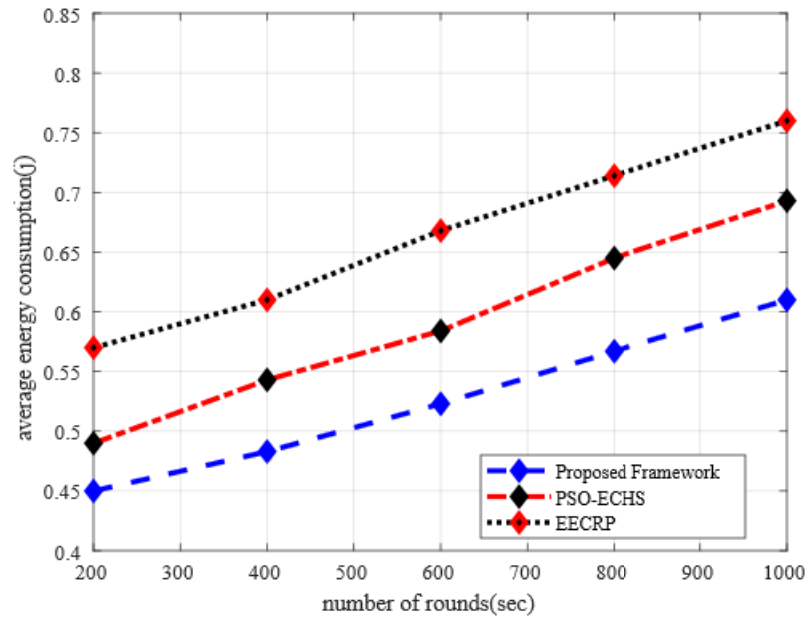
Figure 6. The impact of the simulation rounds on energy consumption.